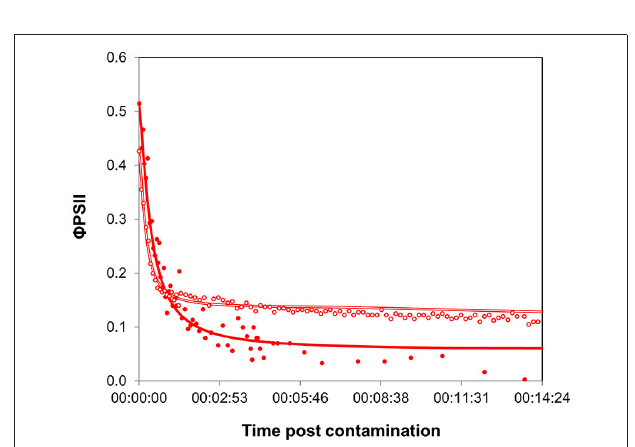
FIGURE 4 | Time-response curves based on ϕ PSII decrease for contrasted biofilms, after contamination at “high” concentration. Full symbols correspond to biofilms collected in August (Experiment 1, average of 3 replicates), empty symbols to biofilms sampled in December (Experiment 2, average of 4 replicates). Parameters extracted from curve modeling are shown in Table 1